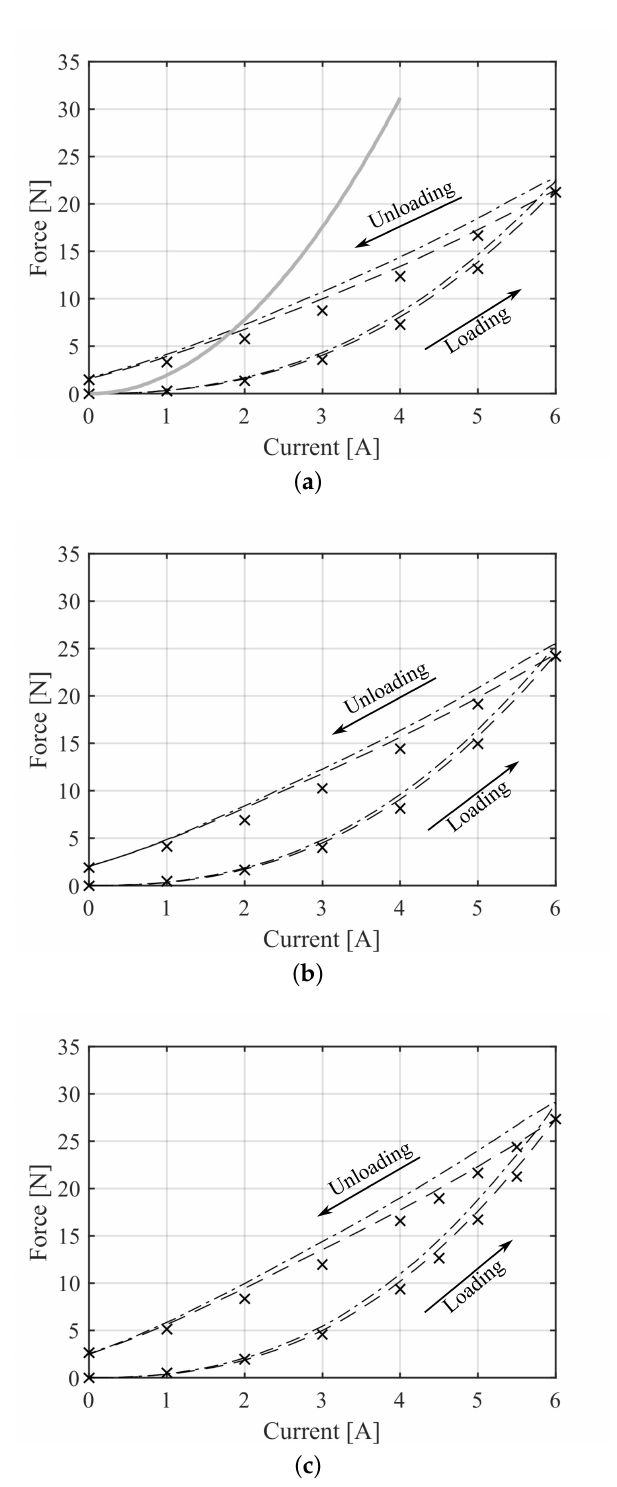
Figure 8. Numerical and experimental forces generated by the system based on the FeCrCo 48/5 journal at 0.55 mm ( a ), 0.50 mm ( b ) and 0.45 mm ( c ) air gap: experimental data (cross); 3D model with magnetic air gap (dashed); 2D model with magnetic air gap (dash-dotted). Loading and unloading curves are related to the current increase from 0 to 6 A and the current decrease from 6 to 0 A, respectively. The grey solid line in ( a ) is the force achieved from the 2D model with magnetic air gap (same as Figure